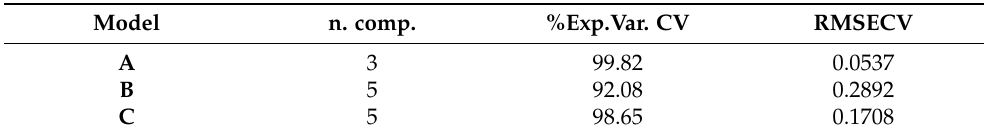
Table 1. The number of components, % explained variance in cross-validation (%Exp.Var.CV), and root mean square error in CV (RMSECV) for PLS models A, B and C.